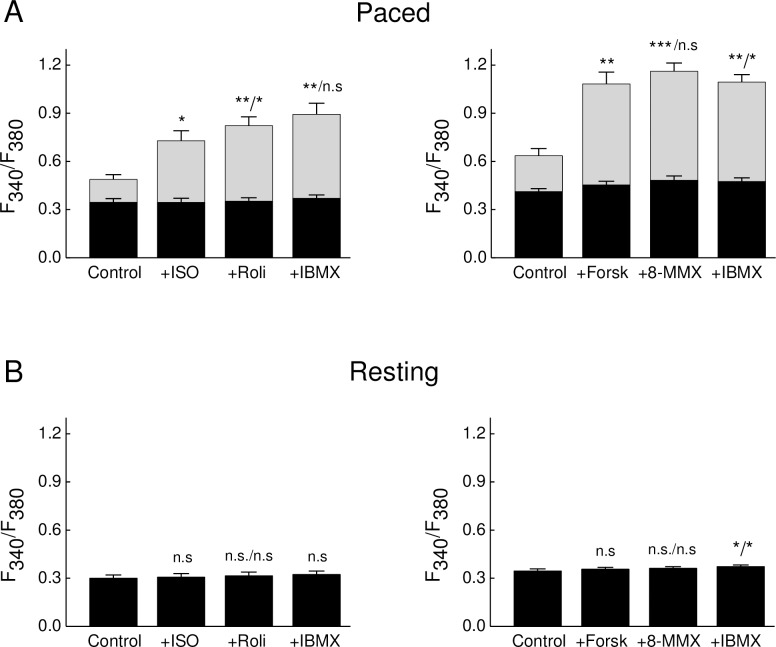
Ca2+ transient amplitudes in ISO and forskolin treated cardiomyocytes.Cells were loaded with Fura2-AM, paced at 1 Hz and treated with 100 nM ISO or 10 μM forskolin with subsequent applications of PDE inhibitors rolipram 10 μM, 8-MMX 30 μM and IBMX 100 μM. Shown are baseline Ca2+ amplitudes (black bars) and systolic Ca2+ transient amplitudes (grey bars) measured in paced (A) and resting (B) cells. Means ± SEM, *—p<0.05; **—p<0.01; ***—p<0.001 with ANOVA (compared to control, second value after / as compared to previous stimulation) followed by the Gasser-Greenhouse correction. n = 7 for ISO and n = 9 for forskolin cells in A, and n = 4 and 5 for ISO and forskolin cells in B, respectively (all isolated from at least 3 mice for each condition). Effects of ISO and forskolin in A are significantly different (p = 0.03 by one-way ANOVA).